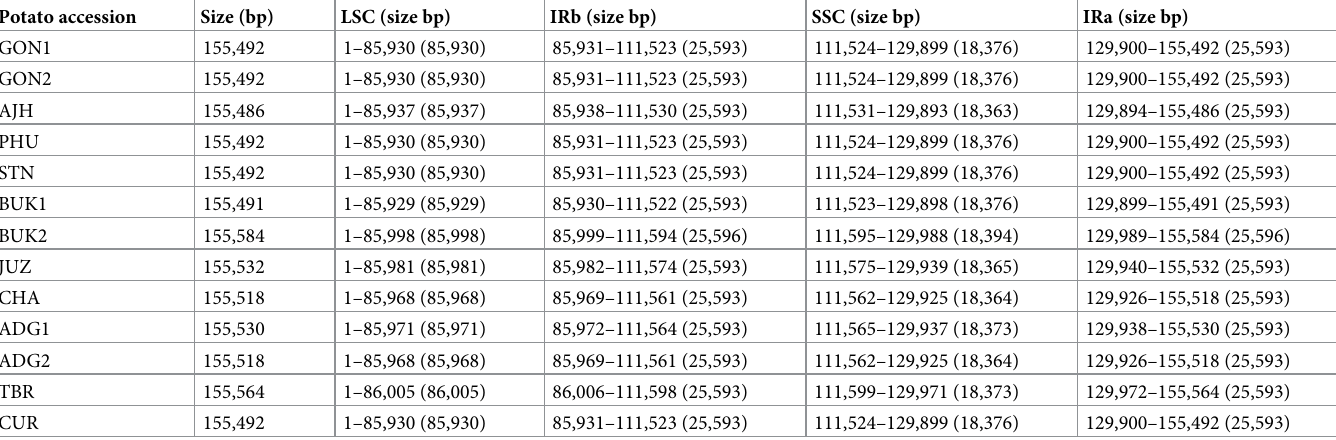
the rRNAs. A total of 14 intronic regions are present in nine genes, of which five are found in the LSC region, three in IR regions, and one in the SSC region. The circular map of the GON1 plastome with the gene structure is shown in Fig 1. The gene structure at the inverted repeat junction sites is similar in all plastomes assembled here, with the exception of BUK2. The JLA (LSC-IRa junction site) is located upstream of the rps19-fragment and downstream of the trnH-GUG gene. The JLB (junction between LSC-IRb) is situated within the rps19 gene. The junction between SSC and IRb is located within the ycf1 and ndhF genes in all of them except in BUK2, where it is located in the intergenic region between these two genes. Furthermore,